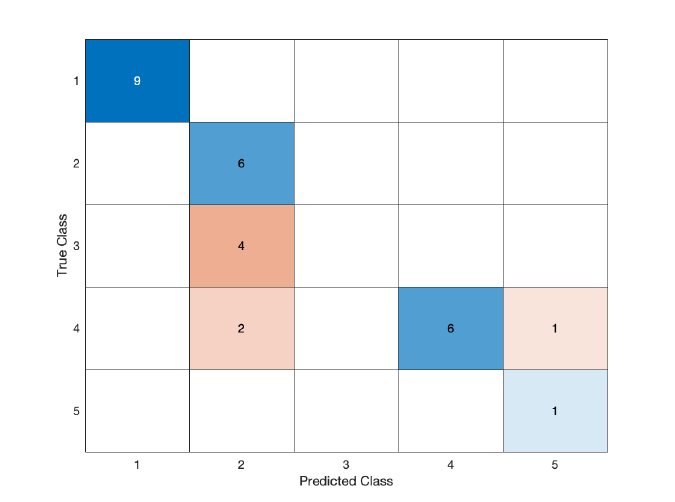
Figure 12. This figure shows the trend of the training progress in the case of a subarea in which the lambda value is equal to 13%.